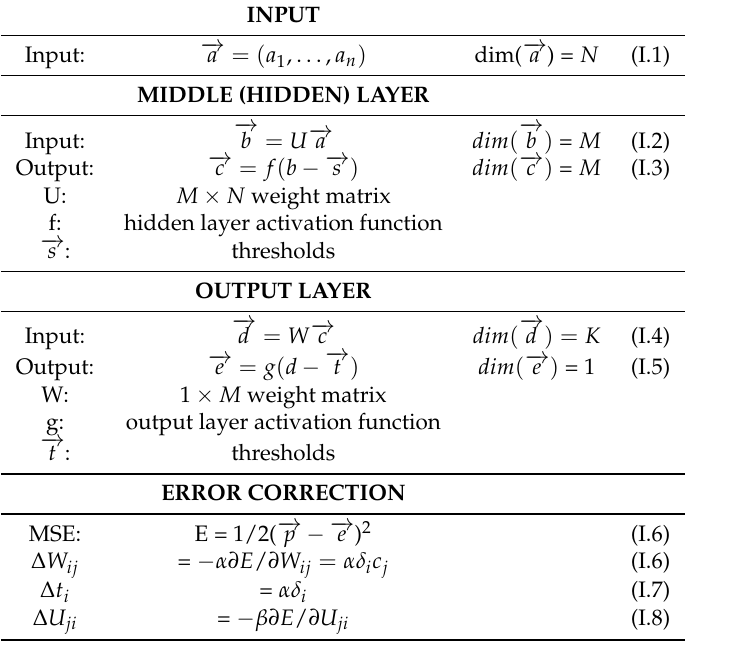
Table 1. Summary of Neural network structure for every image category used in this work.